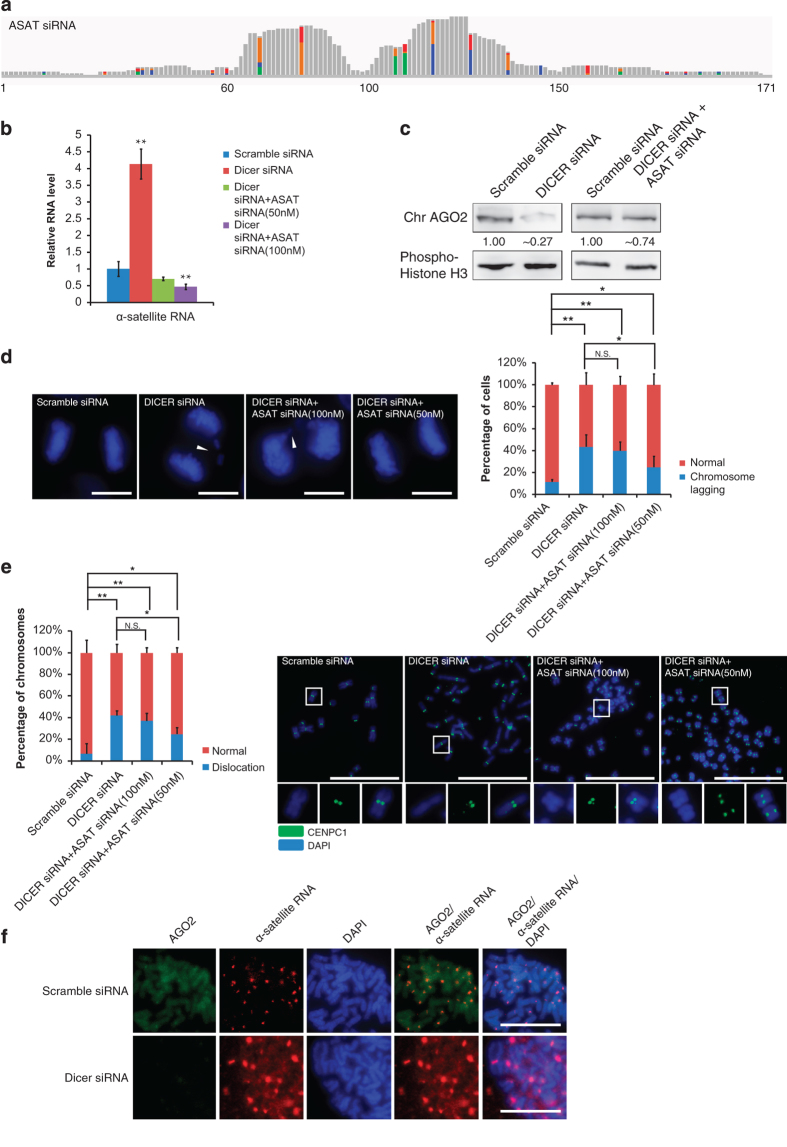
The existence of ASAT siRNA and its roles in chromosome segregation. (a) Bioinformatics analysis of alignment of ASAT siRNAs in HEK293 to the α-satellite RNA sequences. The height of the bars indicates the number of nucleotides covered by ASAT siRNAs. Gray line segment indicates a match, and other colors indicate mismatches. (b) Quantitative PCR to assess levels of α-satellite RNA in RPE-1. Scramble siRNA (negative control), Dicer siRNA (for Dicer knockdown) and Dicer siRNA+ASAT siRNA (Dicer knockdown with the application of exogenous ASAT siRNA). (c) Western blot assay with RPE-1 chromosome samples (treated with 100-nM ASAT siRNA and Dicer siRNA, with scramble siRNA as a control) to detect chromosomal AGO2 (Chr AGO2). Phospho-histone H3, a metaphase chromosomal protein, was used as a loading control. (d) Representative images of chromosome lagging (arrowheads) in RPE-1 cells during anaphase were shown for cells with various treatments. The statistics of the results were shown on the right (n>60 cells per experiment). (e) Immunostaining of CENPC1 on metaphase chromosomes from RPE-1 cells with various treatments. Enlarged images of the boxed area with split and merged channels were shown as inset for detailed view of CENPC1 localization. ‘Dislocation’ refers both unequal loading of CENP-C to centromeres and mislocation to the chromosome arm. Quantification of CENPC1 dislocation was shown with bar figure (n>300 chromosomes per experiment). (f) Co-staining of α-satellite RNA and AGO2 upon Dicer knockdown in RPE-1 cells. Scale bar represents 10 μm for d, and 5 μm for e and f. *P-value <0.05; **P-value <0.01. P-values were determined with two-tailed Student’s t-test. All data were from three repeats. Error bars represent s.d. DAPI, 4′, 6-diaminodino-2-phenylinodole. N.S., not significant.